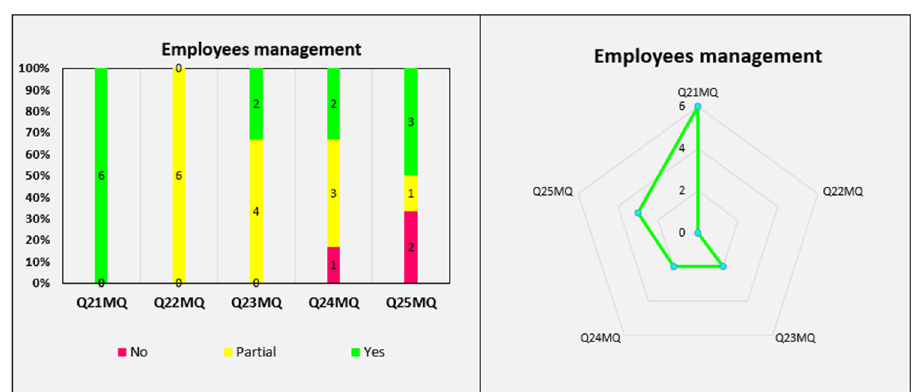
Figure 13. Answers regarding the employee management criteria.